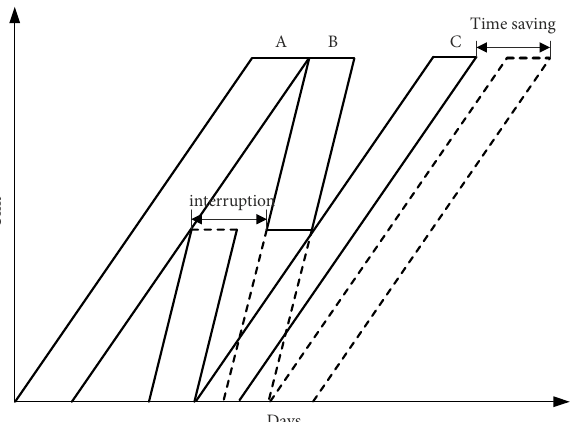
Figure 4. Effect of interruption on project